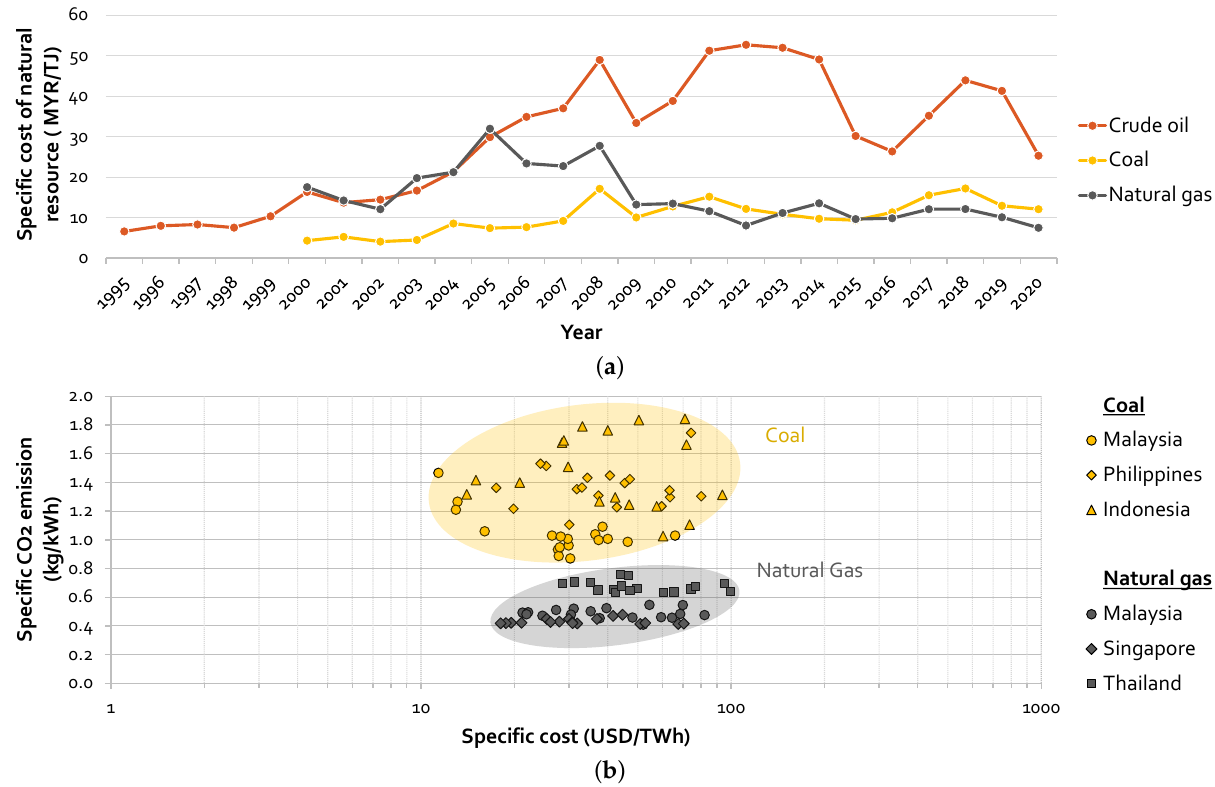
Figure 11. ( a ) Specific cost of resource for 1 TJ of energy input (MYR/TJ); ( b ) specific cost (USD/TWh) and specific CO 2 emission (kg/kWh) of natural coal and coal for ASEAN